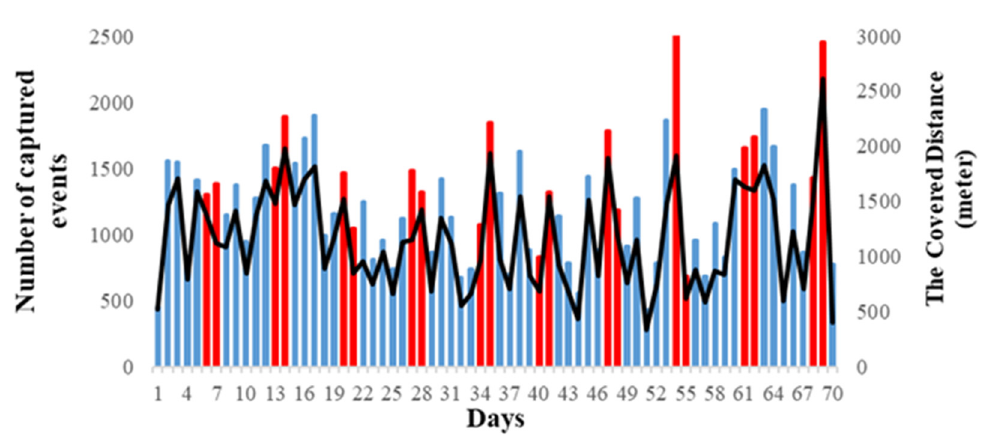
Figure 15. The total number of captured events and total covered distance per day for re-deployment testbed dataset.